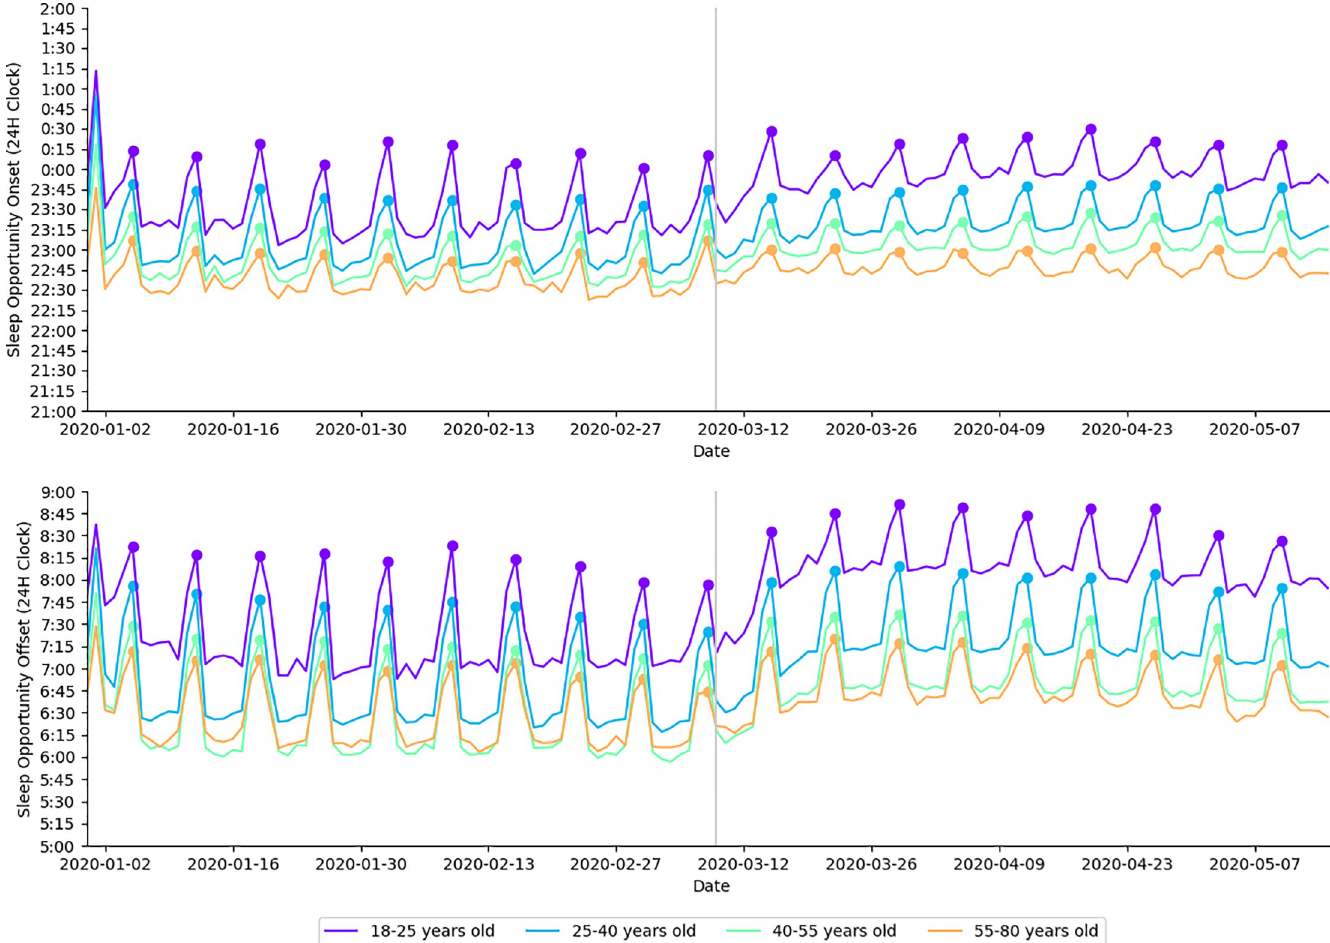
Fig 1. Daily average sleep opportunity onset time and sleep opportunity offset time in 2020 presented by age cohort. Each age cohort is plotted in a different color, indicted in the legend. Filled circles indicate Sundays; a gray vertical line separates baseline and physical distancing.